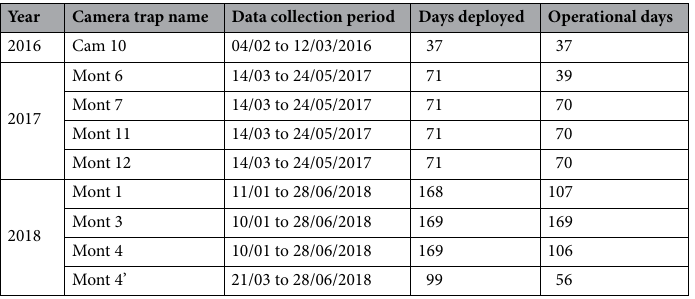
direction of the mean vector, and may not be significant when the species has a bimodal circadian activity. The Rao´s Spacing Test 30 was also performed for the daily activity data, which is based on the uniformity of the spac- ing between adjacent points. In summary, if any of these tests is significant, it can be concluded that the circadian activity of the species is not uniform. Identification of individual animals, population structure and group size. To determine the population structure and size of herds, a detailed inspection of all images from 2016 to 2018 where WDE were recorded and clearly visible, was performed (total of 429 images from 49 events). All images within one event sequence at the individual animal level were analysed, to obtain as much complete information about the number of animals in the herd as possible. From here onwards, one event is reported as being one herd. Where possible, the sex and age category of each recorded animal was determined in every image, according to external traits such as body size, and horn size and shape 31–33 . The sex categories were: male (M), female (F), and unspecified (U), and the age categories were: adult (AD) for animals ≥ three years old, and with three spirals of their horns; subadult, distinguishing between one-year-old (1Y) animals with straight horns, bearing one spiral at the base, and two-year-old (2Y) animals with two spirals, and a specific V shape of the horns; and juveniles (JUV), up to one year of age, with short and straight horns. Animals were identified individually when possible, using specific individual traits and the coat pattern, namely the white stripes unique to each animal 16 . The resulting photographs were assessed for the left (L) and right (R) sides of the animals separately, as in most cases it was not possible to visualize both sides. Thus for fur- ther analyses, the right sides were used because they were more frequent in the images, as similarly reported by Gosling 34 . The rate of identification (ID) success, i.e. the number of identified animals within the age-sex category divided by the total number of individuals recorded in the respective category, was calculated for all years and events together. General Linear Model (GLM) were used in the TIBCO® Statistica™ package (StatSoft, Palo Alto, CA, USA) to determine if the rate of ID success was affected by the respective age-sex category (ADM, ADF, 2YM, 2YF, 1YM, 1YF, JUV), time of day (DAYLIGHT, NIGHT), CT identity, and group size (total number animals in the event). Animals which were not assigned to a specific age-sex category were omitted from this analysis. Despite the different CT efforts in 2017 and 2018, the ratio of age classes was comparable between the two periods, and also with other studies 13,14 , it was therefore assumed that there was an equal trapping probability for all age-sex classes. The total number of individuals of each age-sex category recorded during each camera event was then calculated. Subsequently, the herds were classified into three types: herds with mixed sexes (MIX), male-only herds (UNI-M), and female-only herds (UNI-F). The number of individuals in different herd types was compared, as well as the differences between the group size in 2017 and 2018, and between the seasons (dry, hot dry), using GLM (TIBCO® Statistica™ package, StatSoft, Palo Alto, CA, USA). For those analyses, the single individual recorded in 2016 was omitted. The birth season was estimated based on juvenile horn size (horns are shorter than ears in individuals < four months old) 32 . Given that eland females have one calf per year (with a gestation time range of 255–275 days for Eastern Giant Eland 14 ), and assuming a stationary age distribution and equal probability of sampling for all individuals, the vital rates of the WDE population were calculated 13 , despite of the limitations connected with the lack of long-term data about population dynamics 14 . First, the sex ratio of all detected individuals was calculated, separately for juveniles and adults. By dividing the number of JUV by ADF, the breeding rate was estimated, and the number of JUV and 1Y animals was used to calculate annual mortality rates, firstly for the juveniles: M anJUV = (cid:31) N JUV − N 1Y (cid:30) / N JUV Then, the 1Y and 2Y animals were polled together to obtain the number of subadult animals (SUB), and the annual adult mortality rates for females and males, respectively, were calculated as follows: